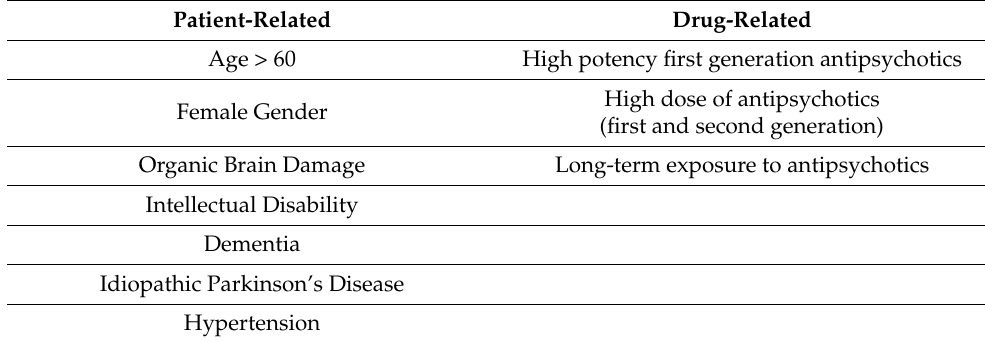
Table 4. Risk factors for